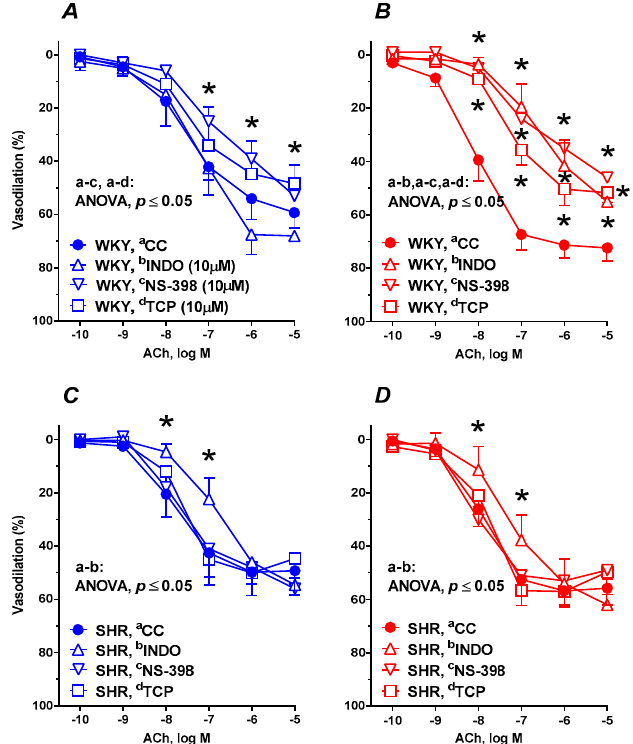
Figure 4. The influence of experimental diets on the vasodilator response to acetylcholine in thoracic arteries isolated from WKYs ( A , B ) and SHRs ( C , D ). From 10 weeks of age, rats were fed a control diet without added raspberry seeds (RBS) ( A , C ) and with a diet supplemented for 6 weeks with added 7% ground RBS ( B , D ). ACh-induced vasodilation was analyzed in the absence and presence of nonselective cyclooxygenase (COX) inhibitor (indomethacin, 10 µ M, 30 min), selective COX-2 inhibitor (NS-398, 10 µ M, 30 min), and prostacyclin (PGI 2 ) synthesis inhibitor (tranylcypromine) TCP, 10 µ M, 30 min). Results (mean ± SEM) are expressed as a percentage of the inhibition of the contraction induced by noradrenaline (1.5 ± 0.18 g), * p ≤ 0.05 (two-way ANOVA / Tukey’s), m = 6–8.